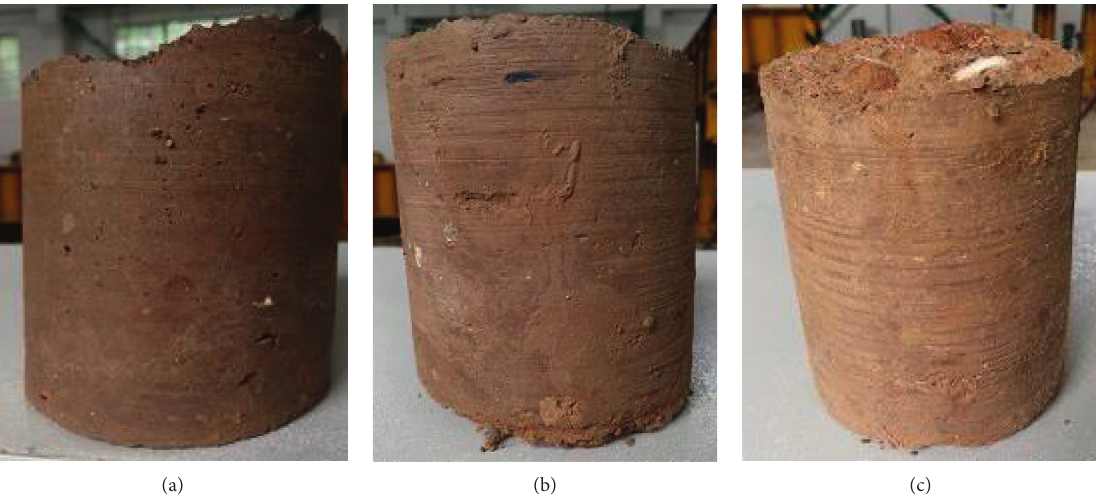
Figure 23: Drill core specimens of each structural layer. (a) Cemented soil. (b) Solidified soil. (c) Fiber-reinforced